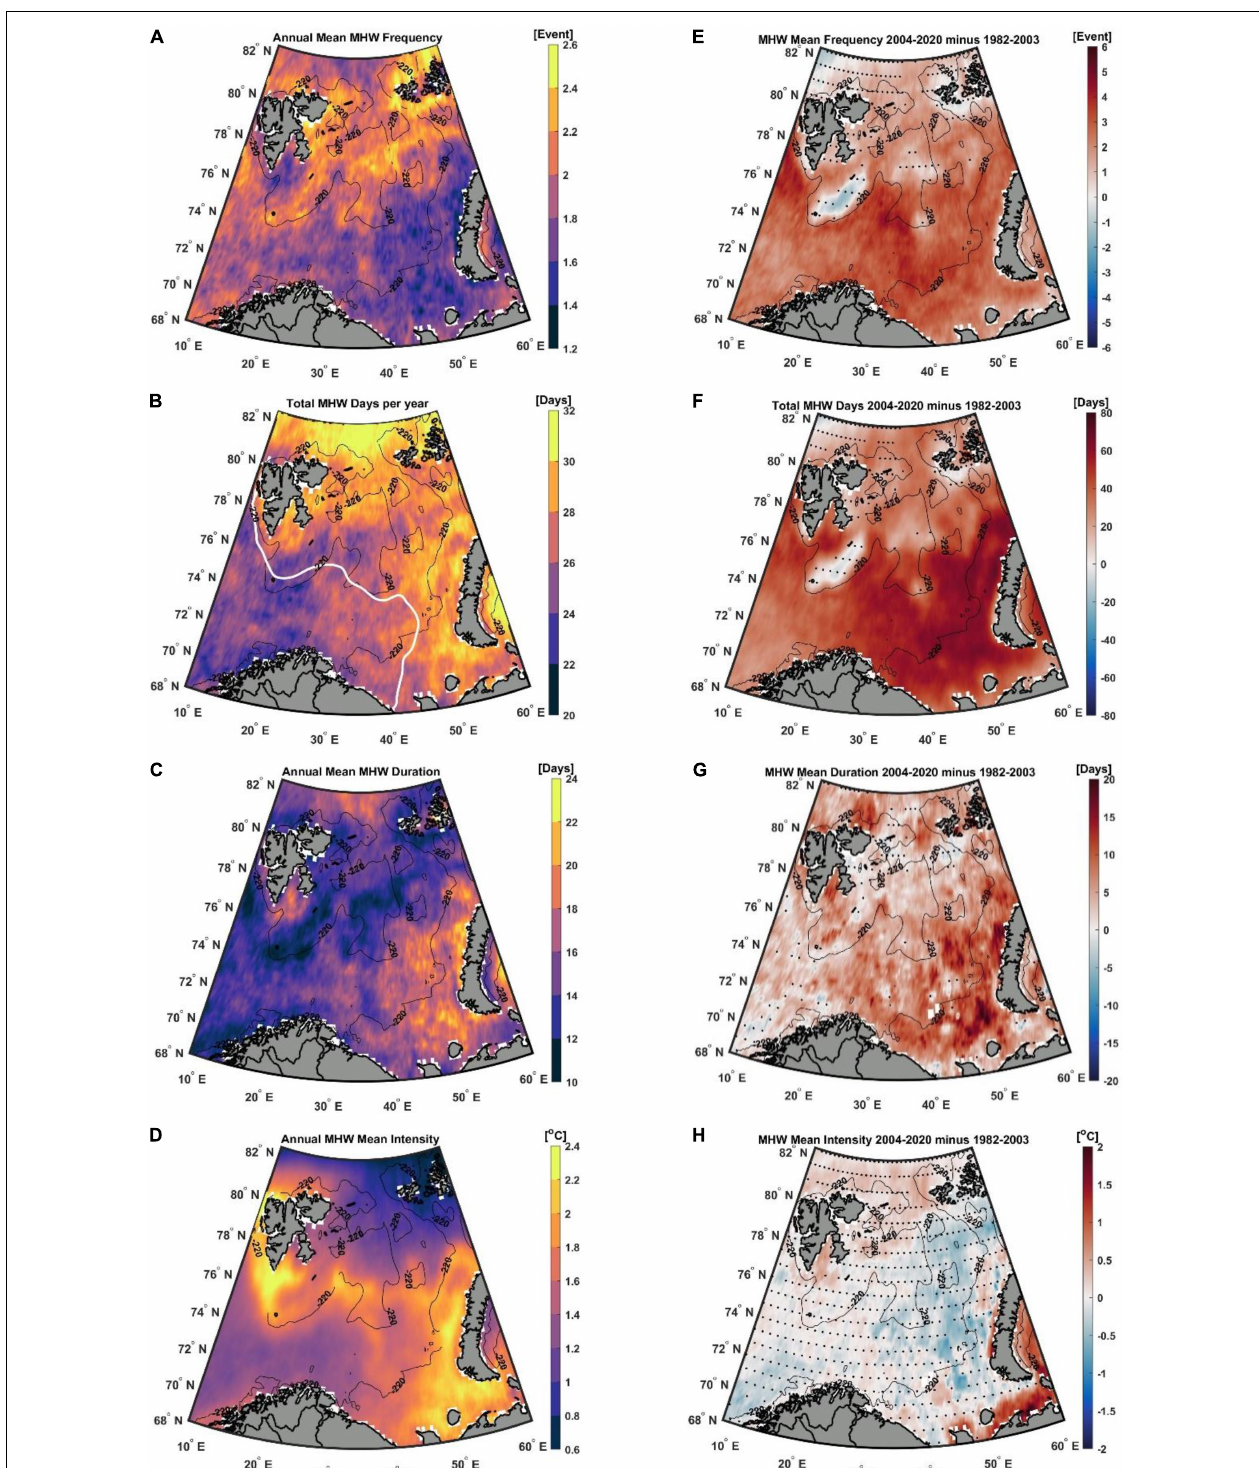
FIGURE 4 | The spatial distribution of the annual mean of the main MHW characteristics in the Barents Sea from 1982 to 2020, (A) MHW frequency (events); (B) MHW Days (days) the white contour line represents the climatological mean of April sea-ice edge (15% SIC ); (C) MHW duration (days); (D) MHW mean intensity ( ◦ C); and difference between the post-2004 and pre-2004 (E) MHW frequency (events); (F) MHW Days (days); (G) MHW duration (days); ( ◦ C); (H) MHW mean intensity ( ◦ C). In (E–H) , stippled regions indicate the change is non-significantly different from zero at the 95% confidence interval ( p > 0.05), based on the standard two-sample Student t -test. The black contour lines indicate the isobath of 220